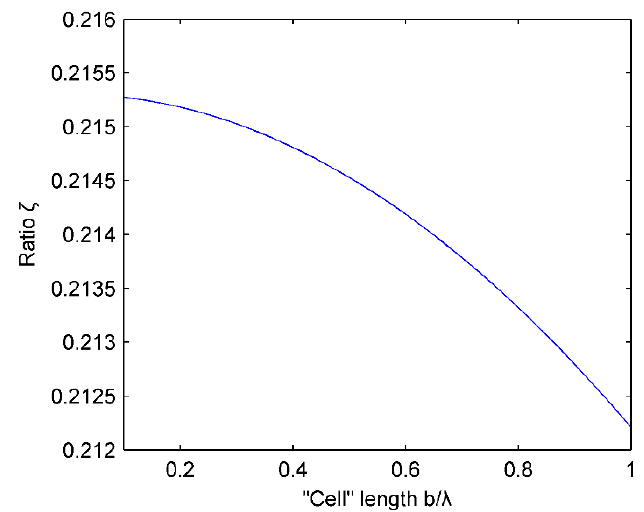
Figure 10. Influence of “cell” length on the ratio ξ .